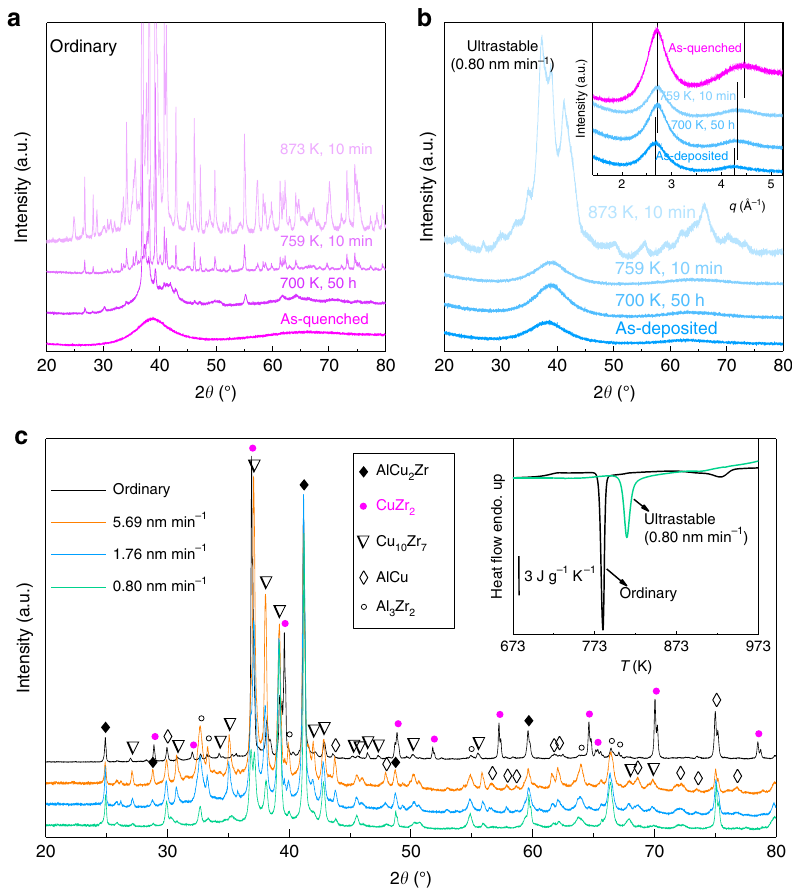
Fig. 2 Crystallization dynamics and phase formation of the ordinary and the ultrastable glasses upon annealing. a , b XRD pro fi les for as-prepared and annealed a ordinary and b 0.80 nm min − 1 deposited ultrastable MGs. The annealing temperature and time are denoted by the legend values above each curve. Inset in b : XRD data for as-deposited and annealed ultrastable MGs and as-quenched ordinary MGs plotted as a function of q = 4 π sin θ / λ . The vertical lines indicate the peak positions. c XRD pro fi les for samples after annealed at 973 K for 1 h, from top to bottom, the ordinary, 5.69 nm min − 1 , 1.76 nm min − 1 , and 0.80 nm min − 1 vapor-deposited glasses. Inset: DSC traces for the ordinary and the 0.80 nm min − 1 deposited glasses at a heating rate of 20 K min −